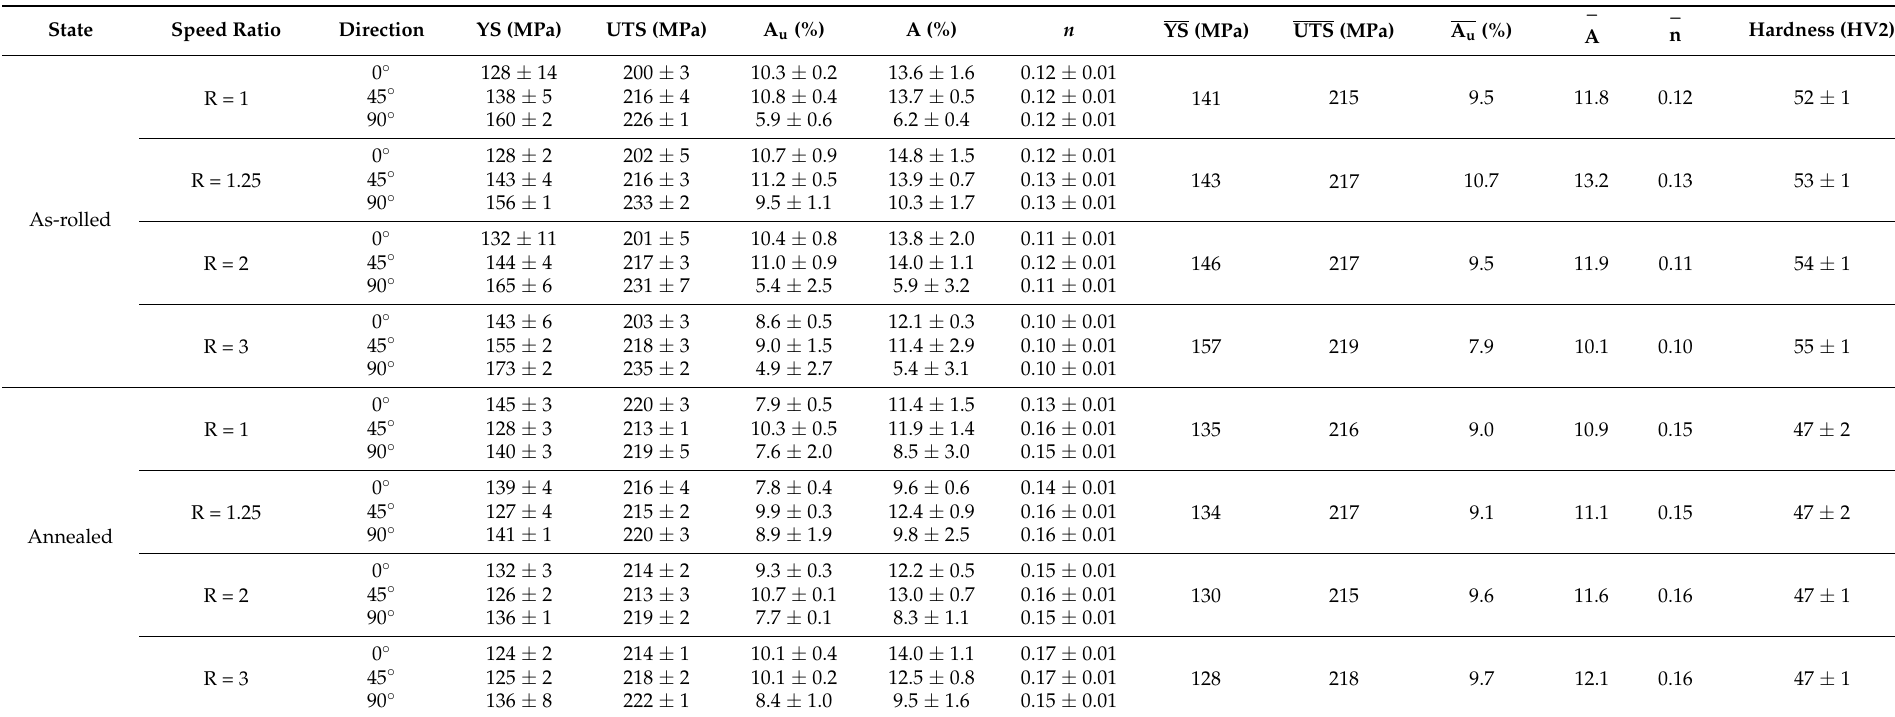
Table 1. Mechanical properties (YS—yield strength, UTS—ultimate tensile strength, A u —uniform elongation, A—elongation to failure, n —strain hardening exponent) of the as-rolled and annealed Mg-6Sn sheets processed with different speed ratio.